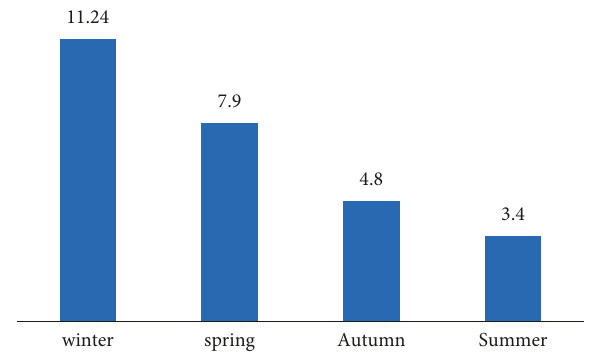
Figure 4: Seasonal variation of Cryptosporidium bovis infection in calves in Egypt.